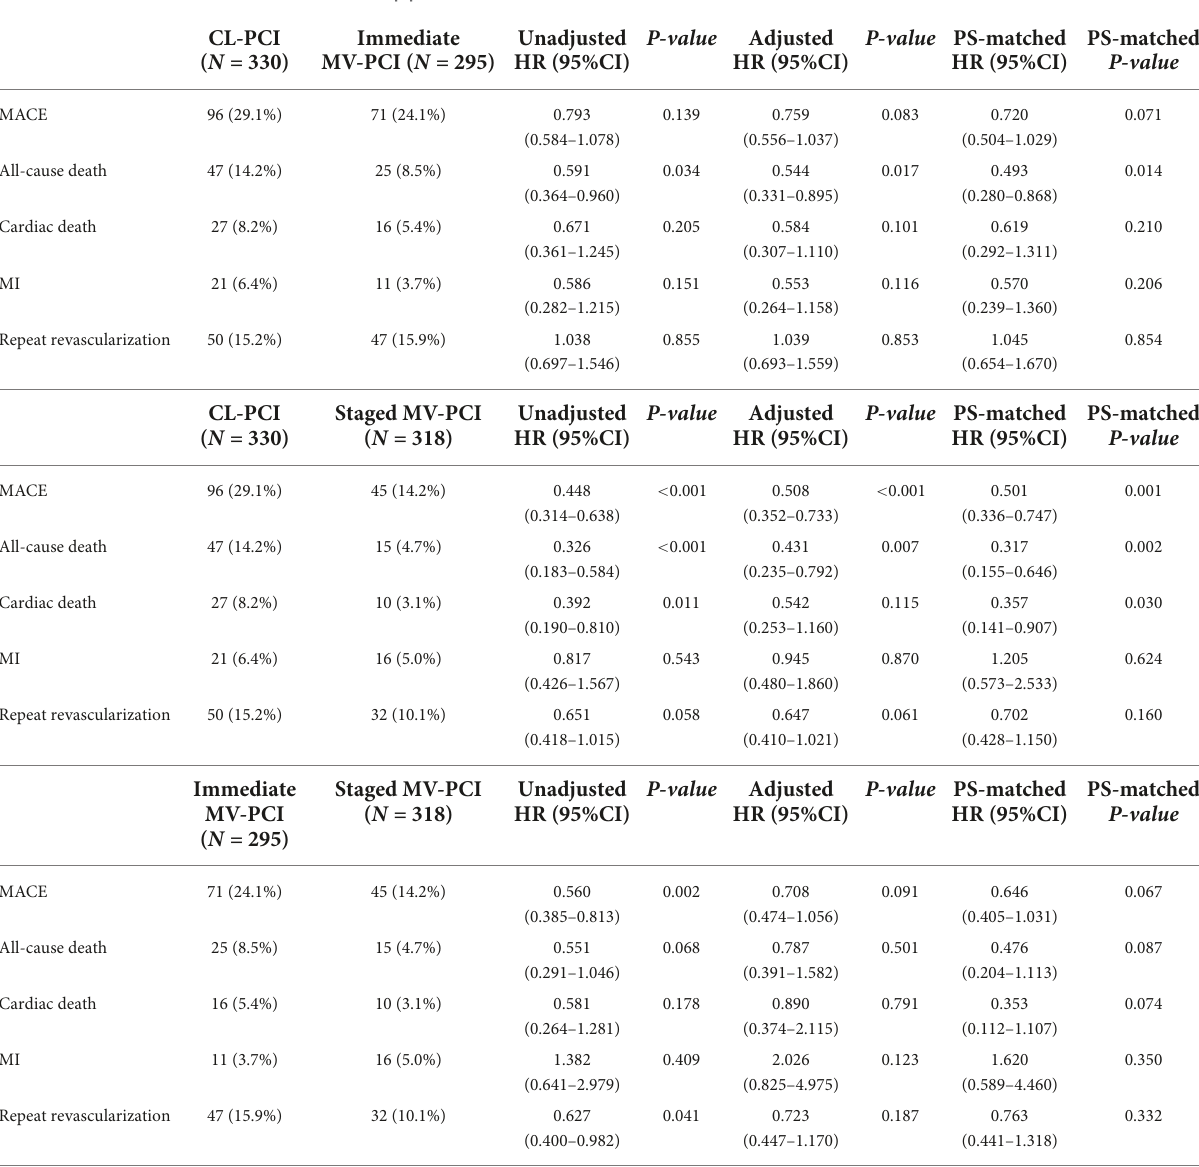
TABLE 3 Clinical outcomes over entire follow-up